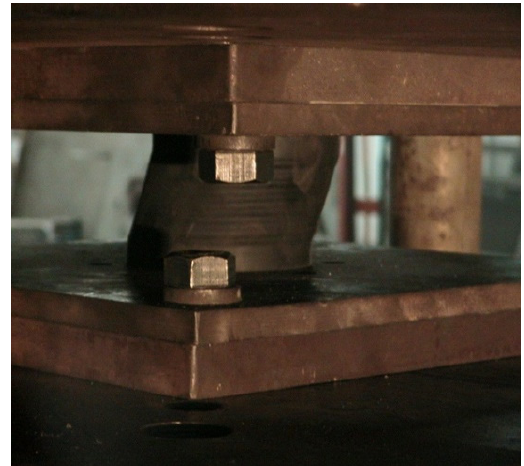
Figure 4. Shear test of rubber bearing under axial pressures.